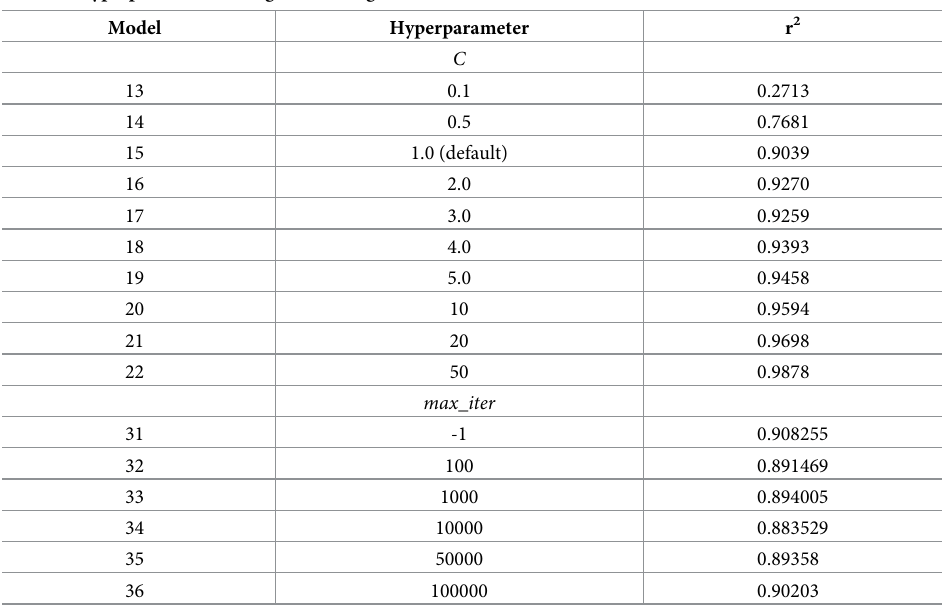
Table 2. Hyperparameter tuning for SVR regressor.